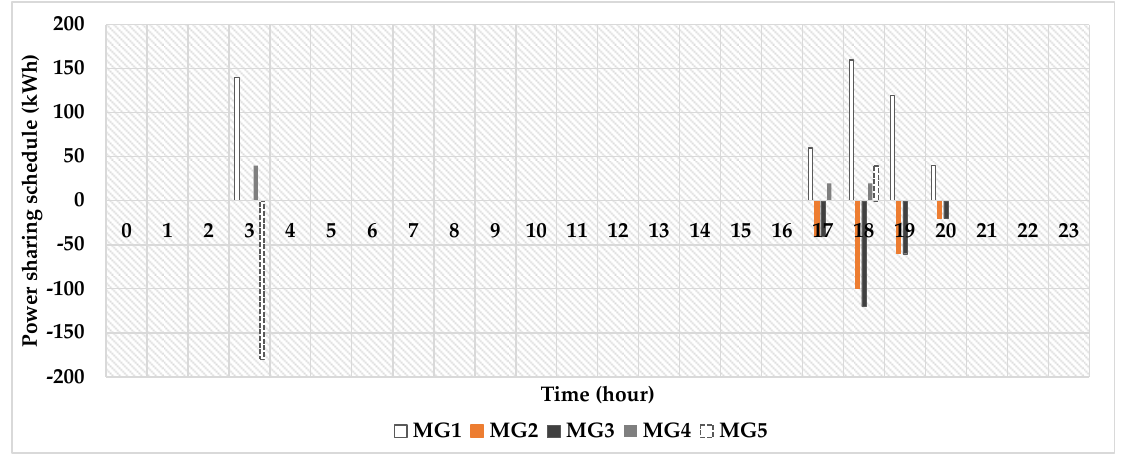
Figure 8. Power sharing schedule determined by the proposed method.